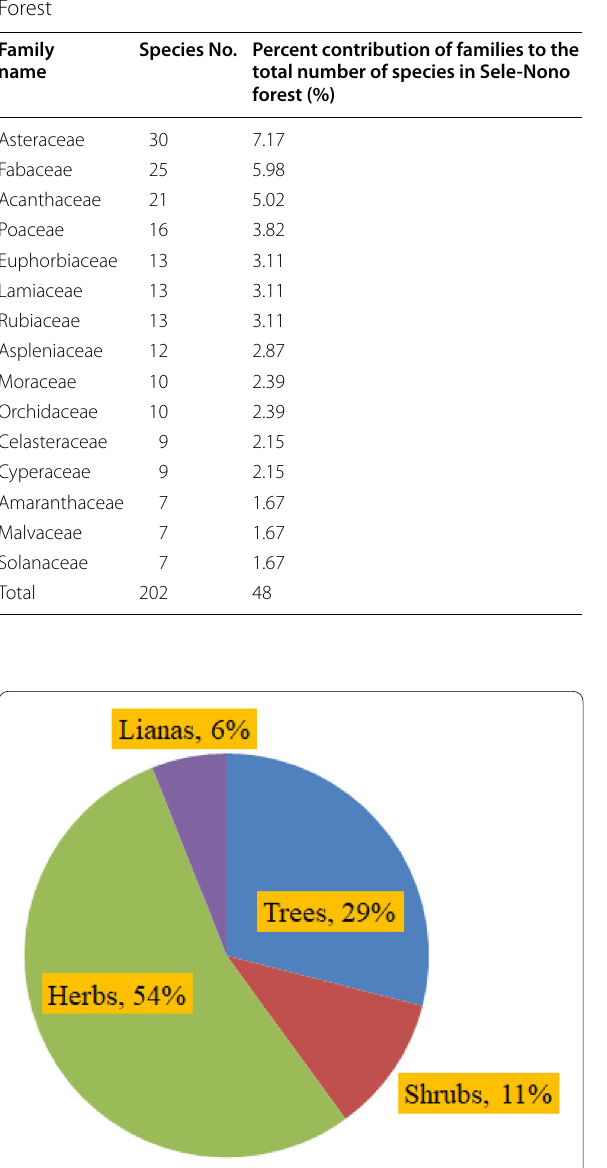
Fig. 6 Growth forms of plant species collected in Sele-Nono